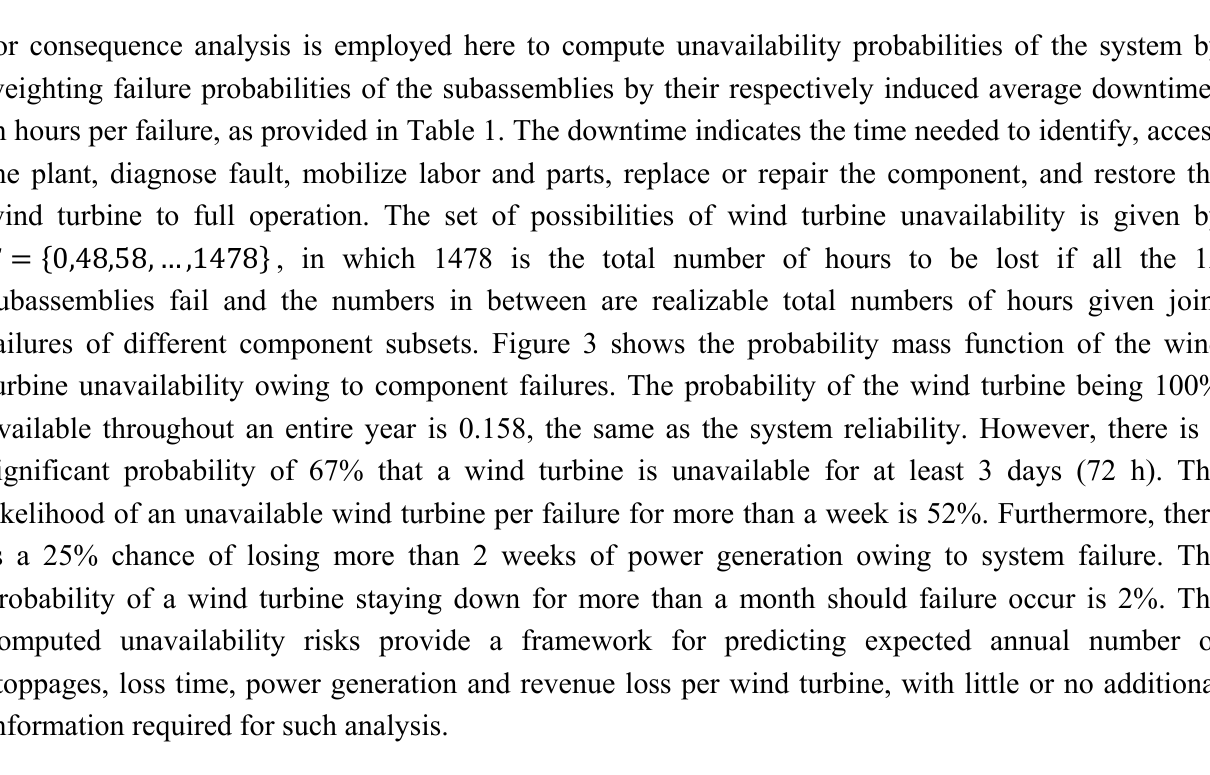
Figure 3. Probability distribution of the 12-subassembly wind turbine